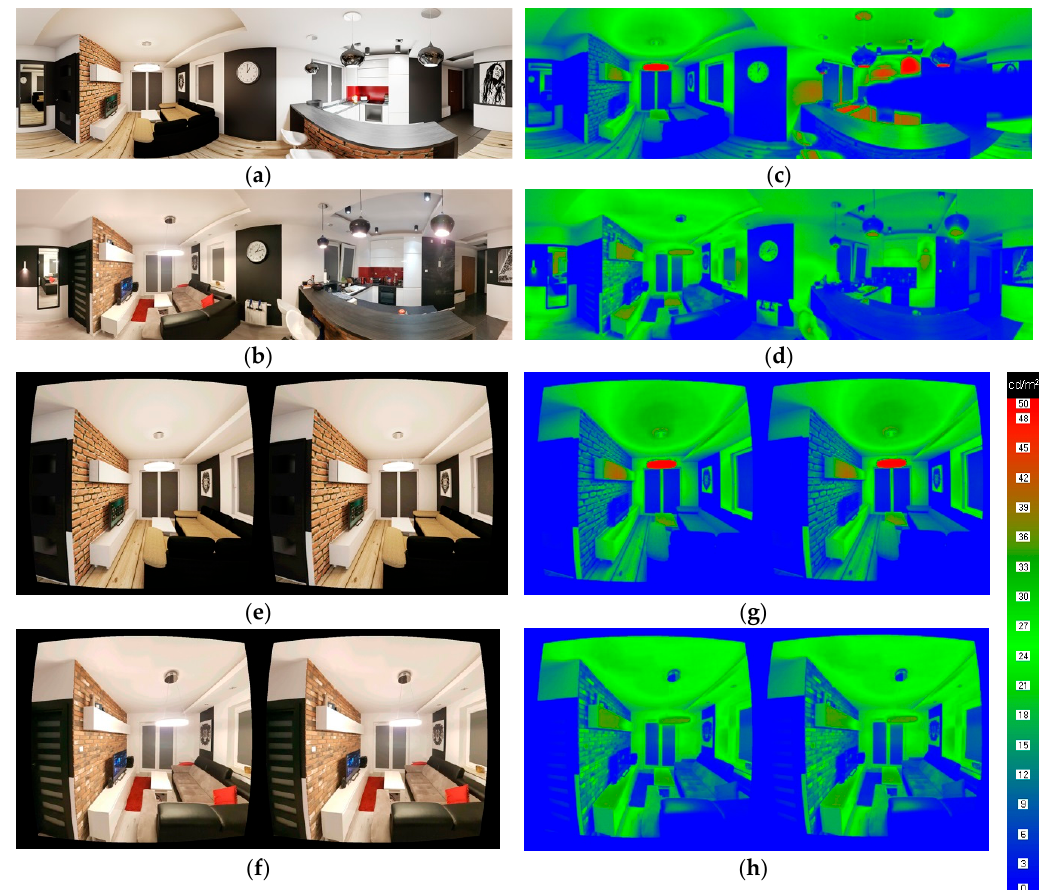
Figure 5. Calibrated visualisation and photograph images with measured luminance distributions [cd/m 2 ]. ( a ) Object visualisation in 360 deg technology; ( b ) Photograph in 360 deg technology; ( c ) luminance distribution of visualisation in 360 deg; ( d ) luminance distribution of photograph in 360 deg; ( e ) VR visualisation for left and right eye; ( f ) VR photo for left and right eye; ( g ) VR luminance distribution of visualisation for left and right eye; ( h ) VR luminance distribution of photo for left and right